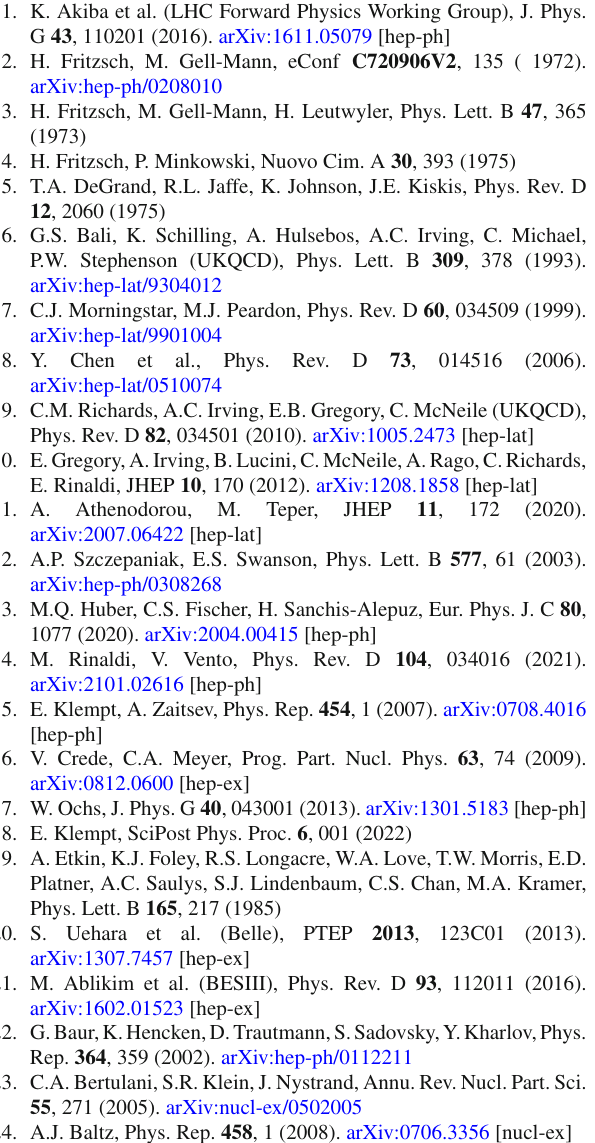
Table 2 Cross sections and associated number of events in the tensor glueball decay mode G 2 → φφ for the tensor glueball production in PbPb collisions. The integrated luminosities selection